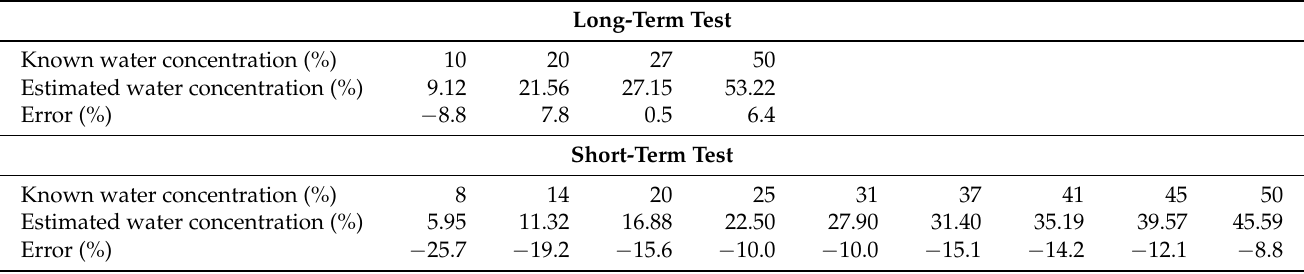
Table 1. The known (added water) and estimated (calculated using the linear model and the measured propagation velocity) water concentrations and the percentage relative